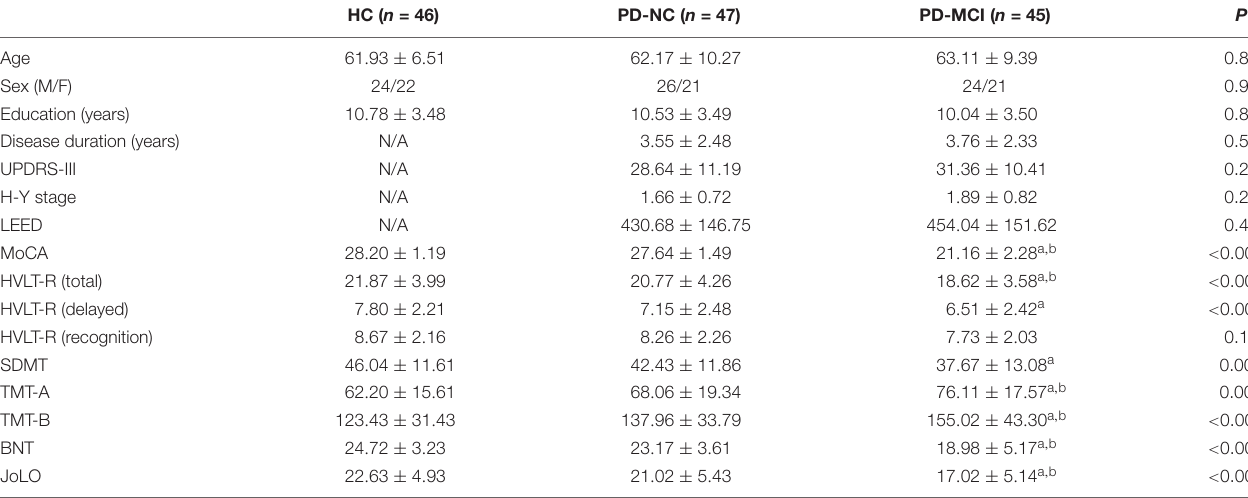
TABLE 1 | Demographic characteristics and scores of clinical